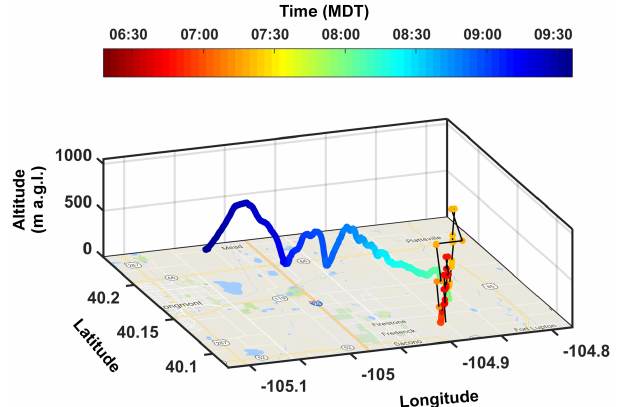
Figure 2. Four-dimensional flight path of HOVERCAT during the 25 May 2017 test flight, colored by time in mountain daylight time (MDT). Black lines between data points indicate missing GPS data, which occurred between 07:01–07:07 and 07:23–07:51MDT. Me- ters a.g.l. were calculated by subtracting 1490 from ma.m.s.l. to roughly show the altitude above